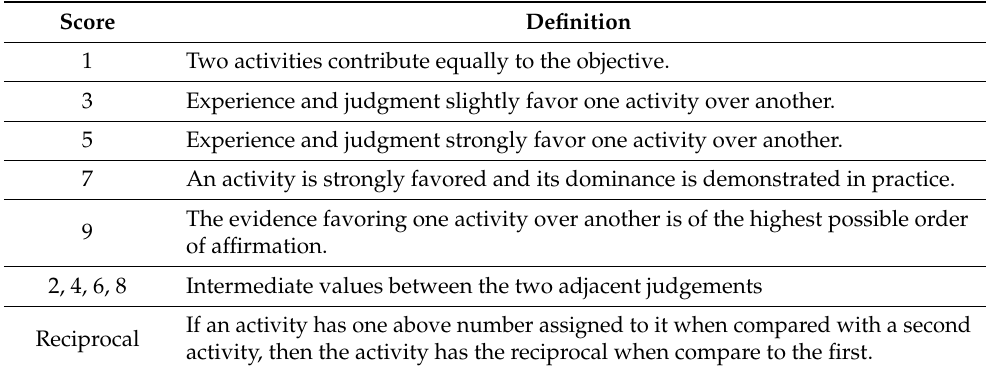
Table A5. Scoring Instructions.